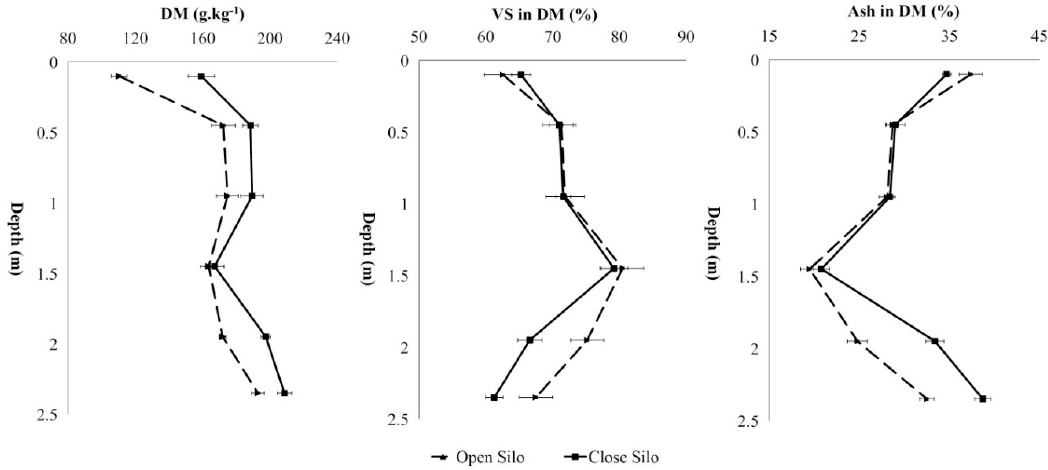
Figure 1. DM, ash and VS content in dry matter in ensiled sugar beet pulp by depth from the pulp surface. Bars indicate standard deviation from laboratory replicates.